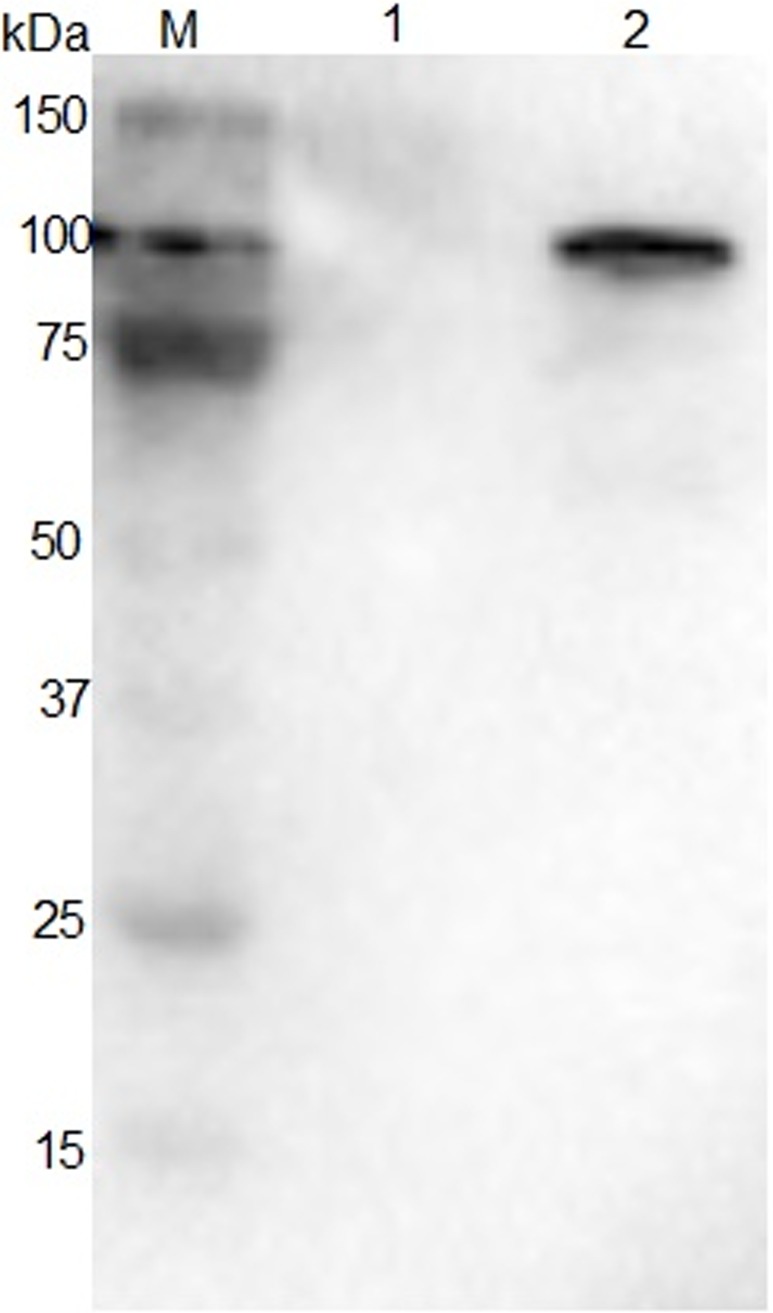
Western blot of JC8031 recombinant strain reacted with corresponding mouse anti-sera.Lane M: protein marker. Lane 1: JC8031- pBAD. Lane 2: JC8031- pBAD -Apxr.